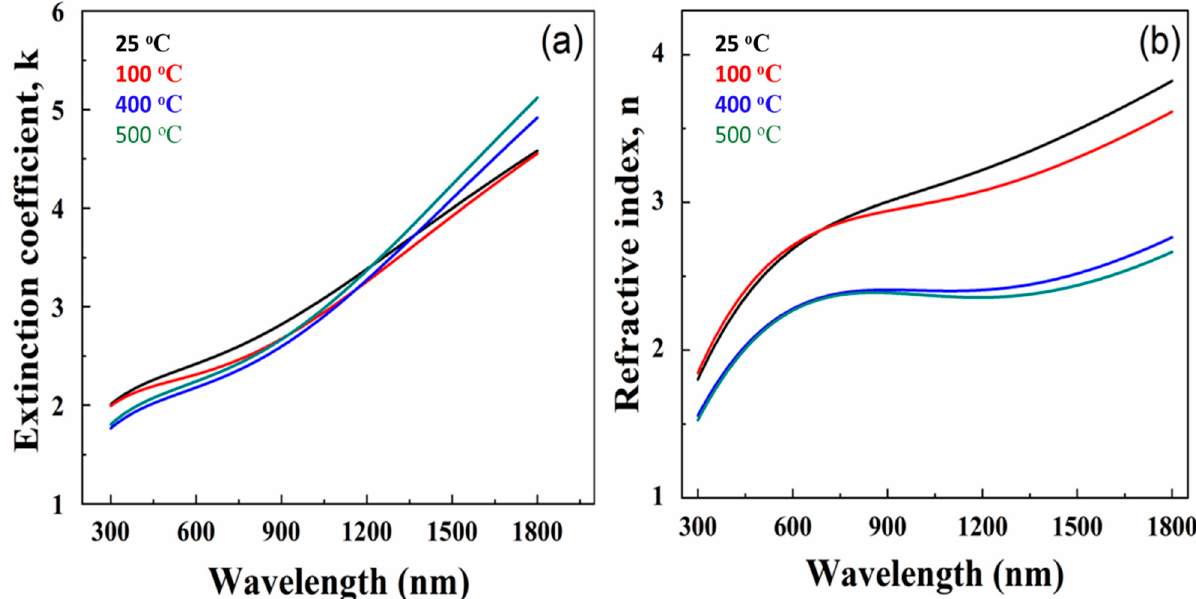
Figure 8. ( a ) Extinction Coefficient (k), and ( b ) Refractive index (n) as a function of wavelength. Data are shown for samples at 25 °C, 100 °C, 400 °C, and 500 °C.